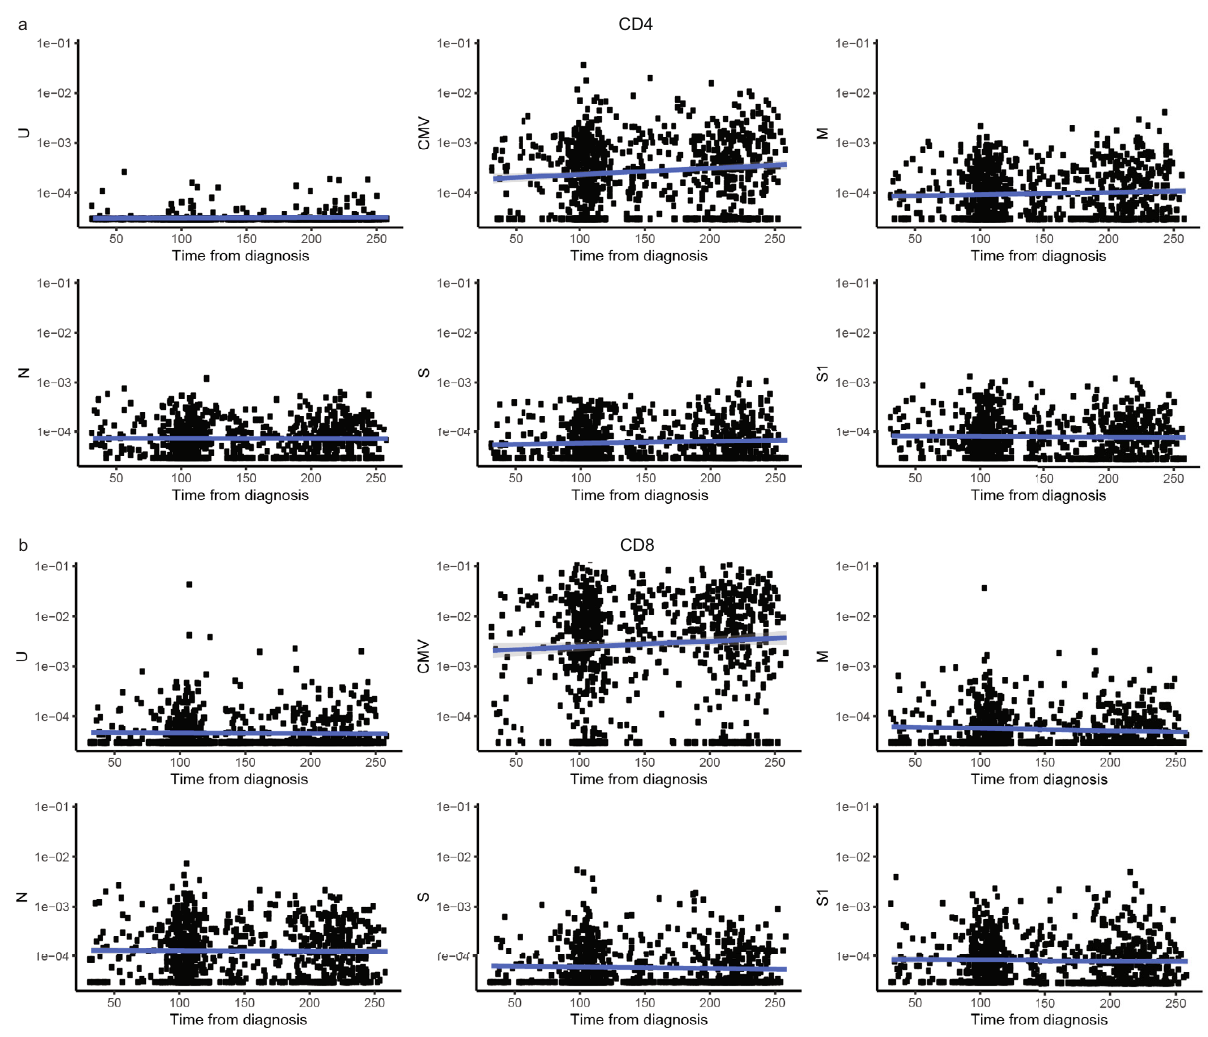
Fig. 4 SARS-CoV-2 induced T-cell responses do not decline in the fi rst 8 months after diagnosis. Cross-sectional analysis of SARS-CoV-2 reactive a polyfunctional CD4 + and b all IFN- γ + CD8 + T-cells from all subjects in the study where samples were collected up to 259 days from diagnosis. Y-axes shows percentage of polyfunctional a CD4 + ( n = 862 samples) and b CD8 + ( n = 859 samples) T-cells responding to the stimulation indicated on the Y-axes (U, CMV, M, N, S, or S1). Y-axes indicate time from diagnosis in days. The solid blue line indicates the logistic-regression line and the gray area around the blue line indicates the 95% con fi dence intervals (CI). Correlation between T-cell responses was estimated using Spearman ’ s correlation coef fi cient and a Jackknife method was used to calculate con fi dence